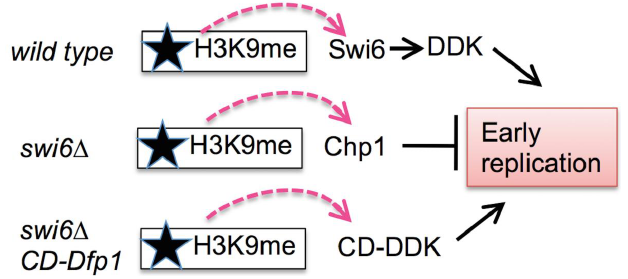
Figure 3 Figure 3. Model for replication